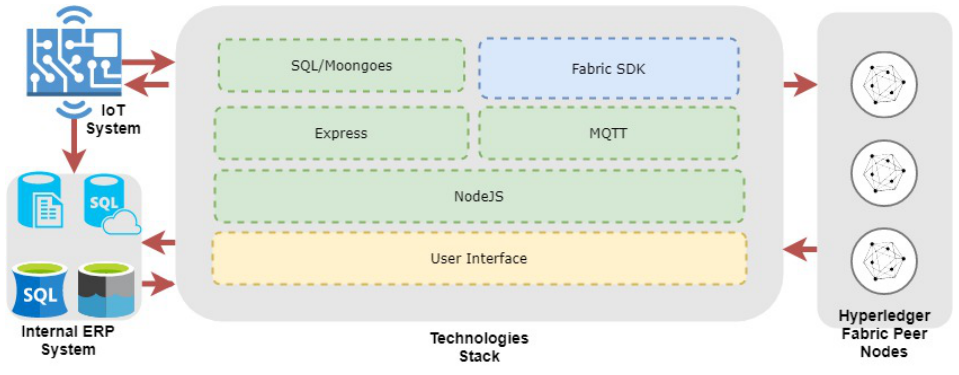
Figure 10. Blockchain Technological Stack to Developed Blockchain